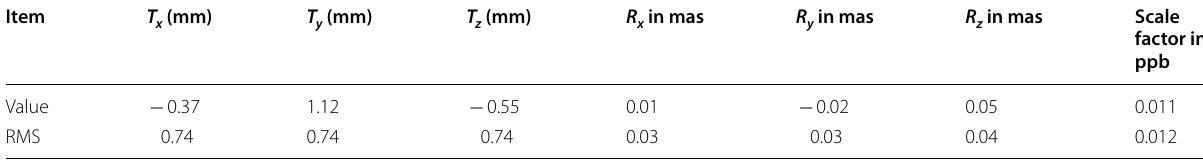
Table 2 Seven parameters of conversion between BDCS and ITRF2014